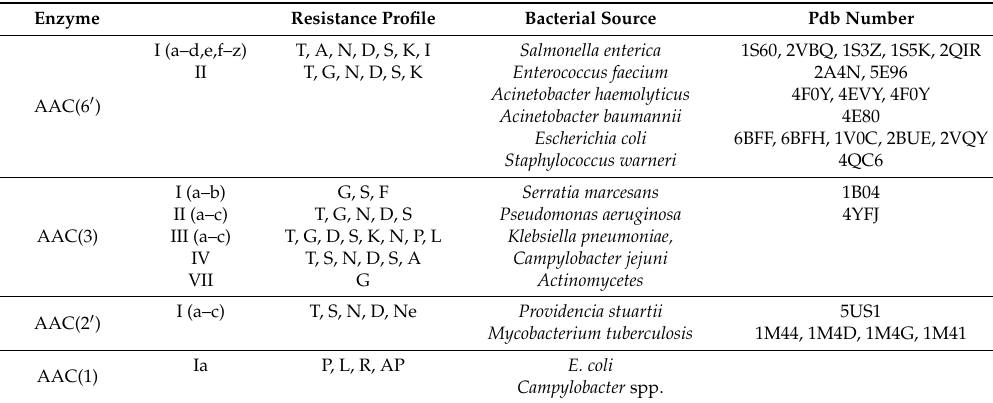
Table 1. N -acetyltransferase (AAC)-modifying enzymes.